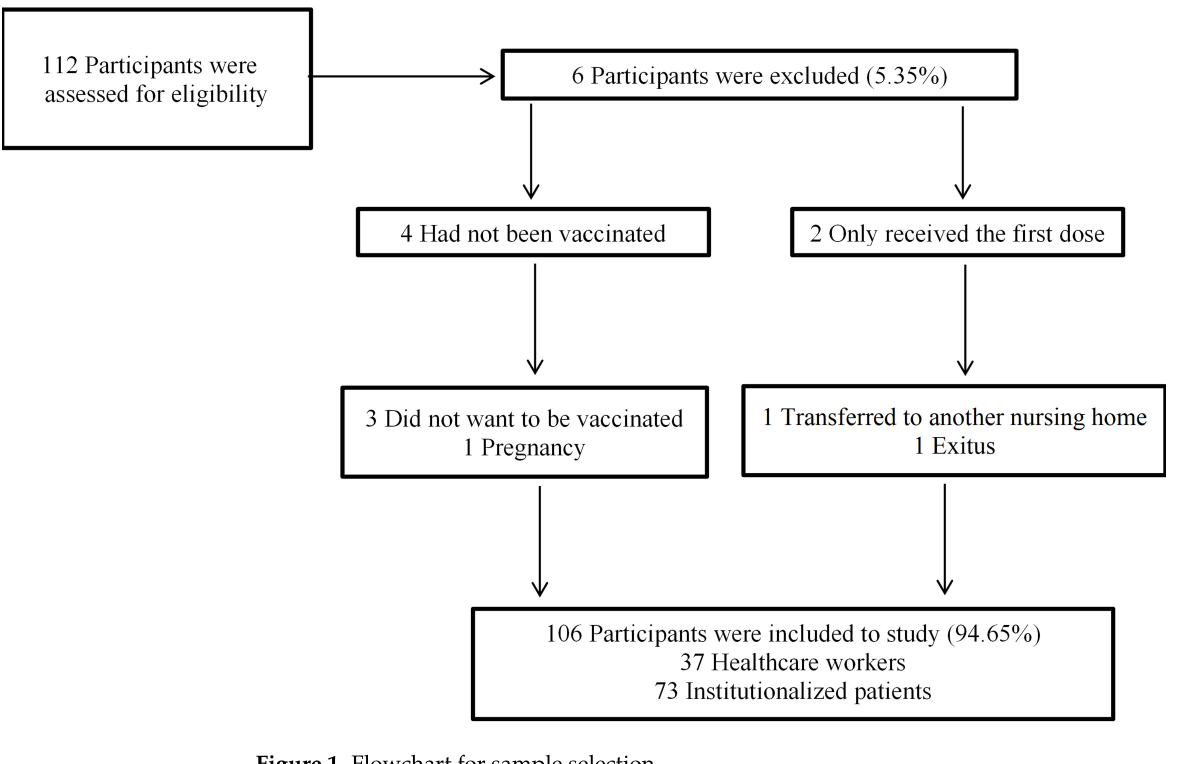
Figure 1. Flowchart for sample selection.